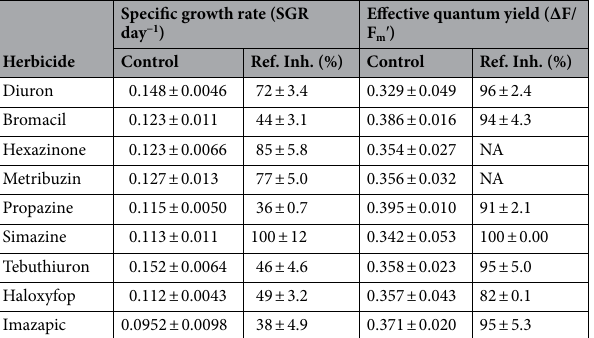
Table 1. Assay performance of solvent control and reference toxicants (6 μg L −1 diuron) for each of the nine herbicides tested over 14 days (SGR, n = 4–6 reps; ΔF/F m ′ , n = 3). Mean ± SD. Ref. Inh. (%) denotes percent inhibition of reference toxicant relative to control. NA denotes data not